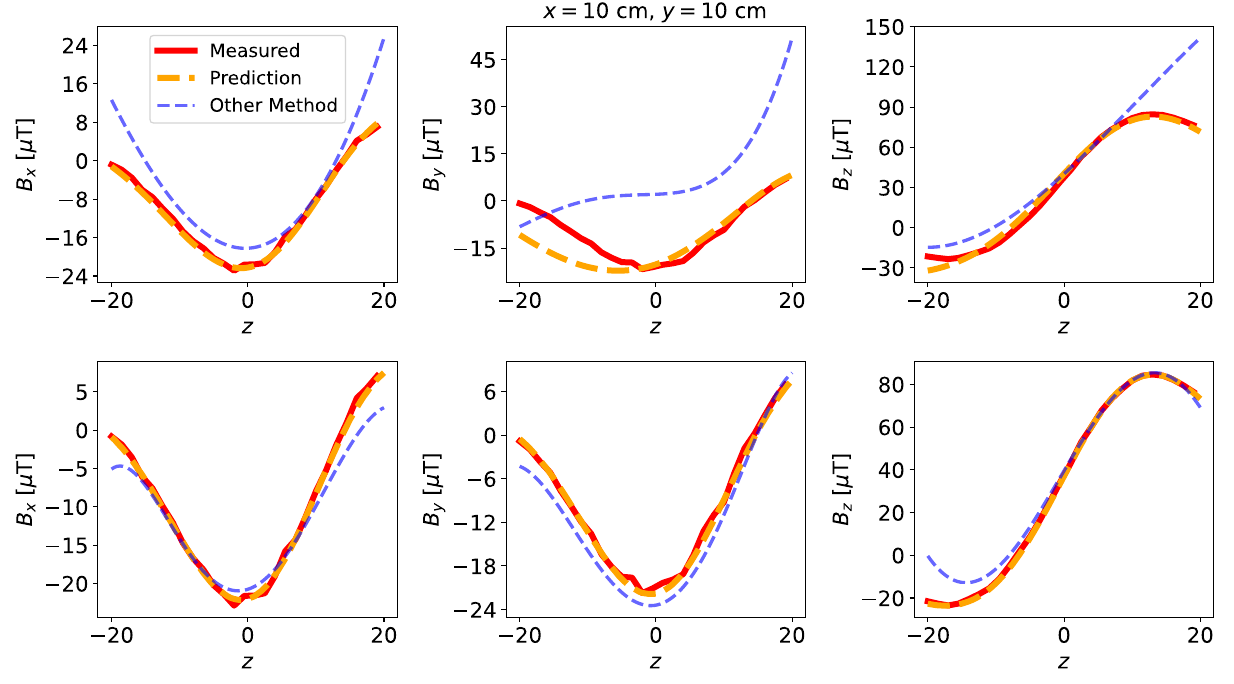
Figure 7. Comparison of the predicted and the other method’s solutions along x = 10 , y = 10 axis. Top: 18 sensor data, bottom: 30 sensor data.